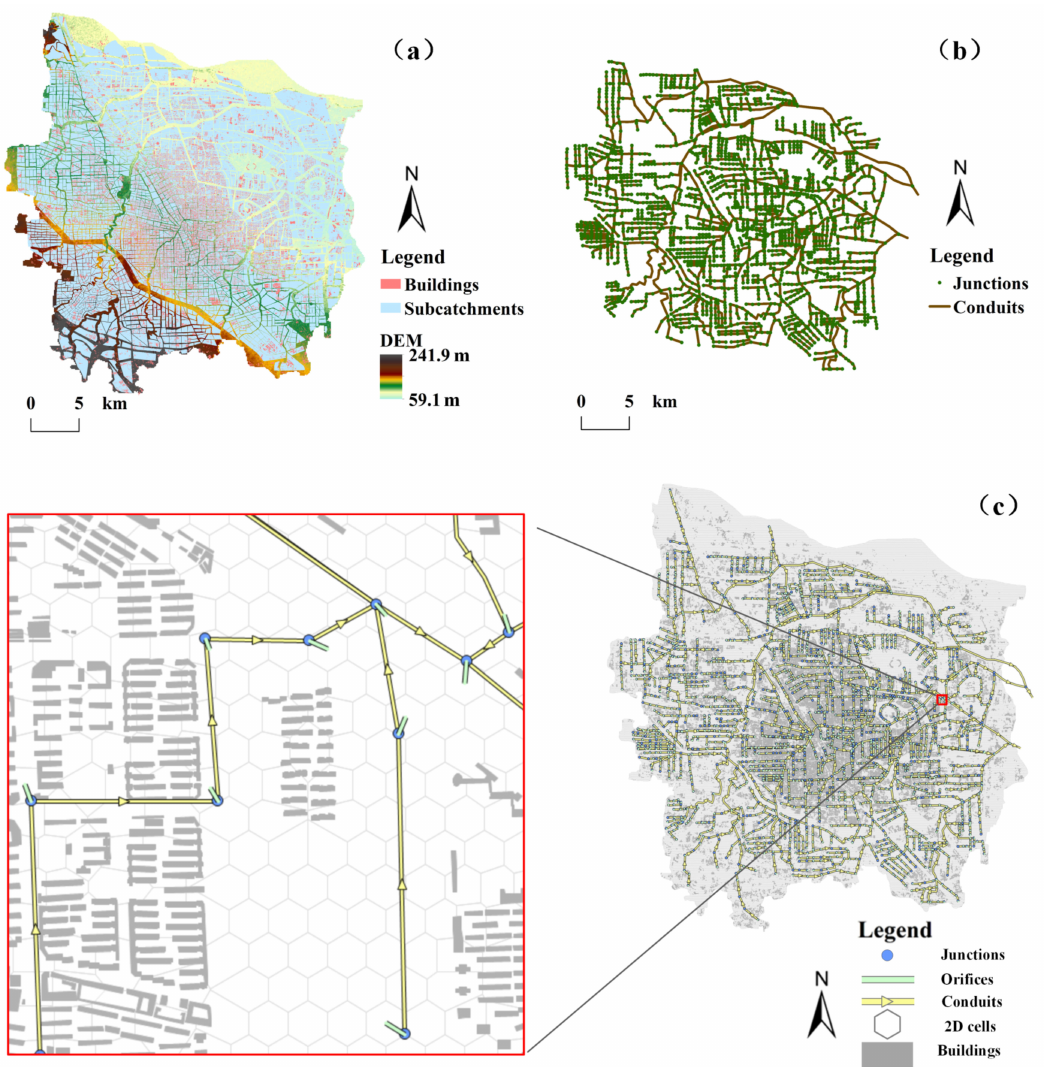
Figure 4. ( a ) Distribution of sub-catchments and buildings; ( b ) distribution of junctions and conduits; ( c ) link of one-dimensional conduit model and two-dimensional floodplain